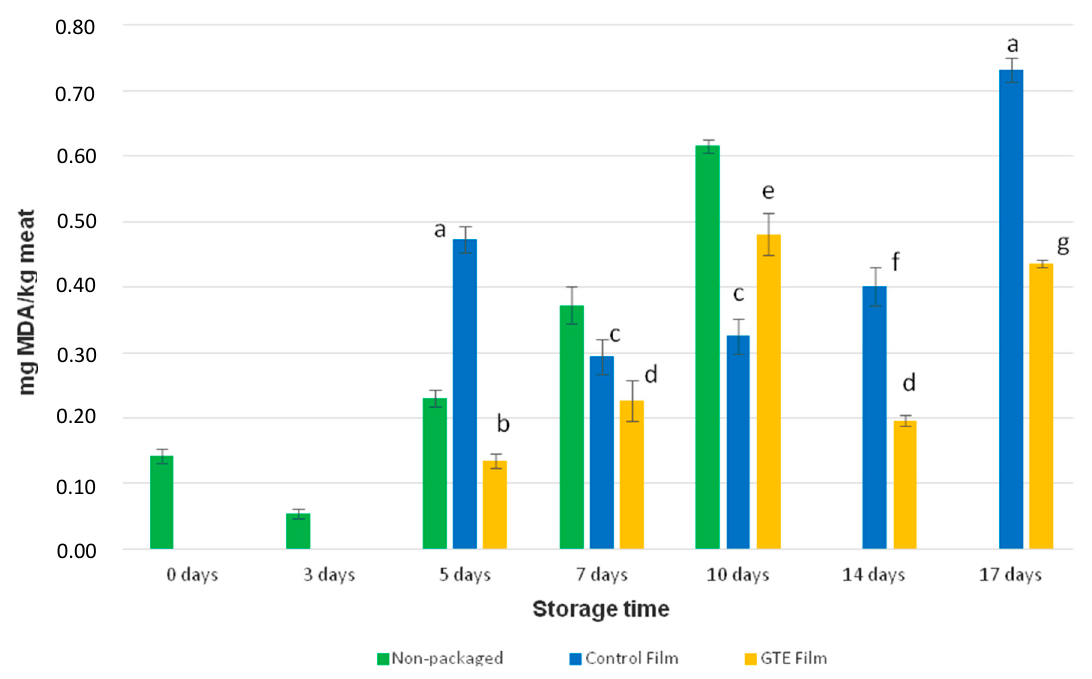
Figure 3. Results of TBARS assay for fresh salmon samples packaged with the control film (without GTE), packaged with the active film (with GTE) and non-packaged salmon. The red line stands for the threshold of off-odor perception by consumers. MDA—Malonaldehyde. Different letters are for significant differences ( p < 0.05).